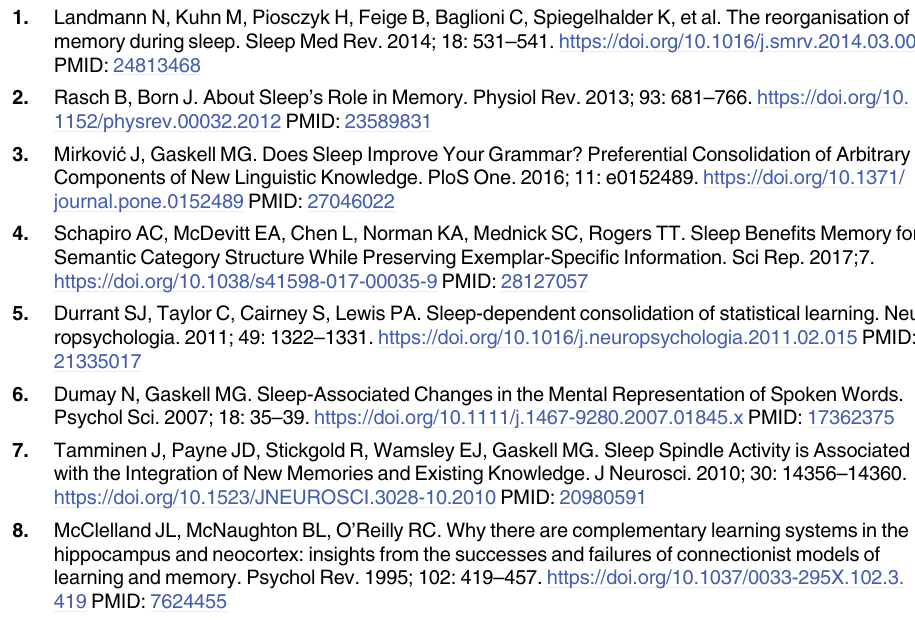
S2 Fig. Change in generalization across sessions (Test 2 generalization–Test 1 generaliza- tion). (PDF) S3 Fig. Functional judgments for trained satellites. (PDF) S4 Fig. Overall slider response